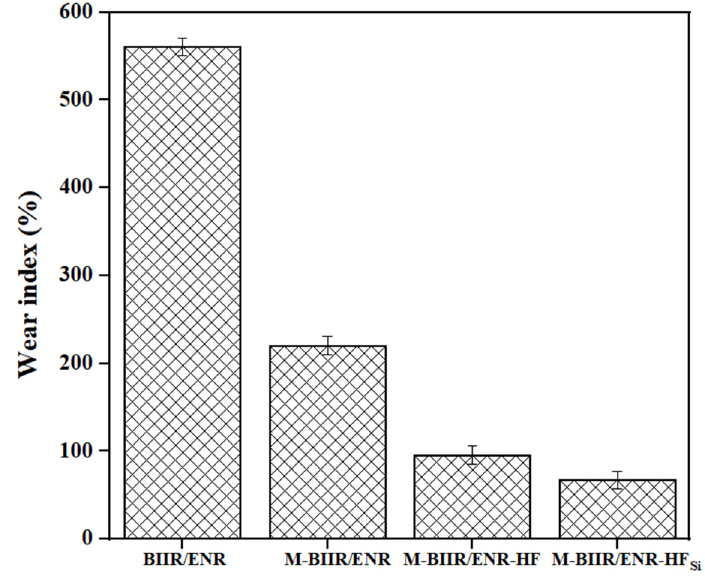
Figure 7. Wear index of unmodified BIIR and the M-BIIR/ENR composites filled with CNT/CB with and without the addition of TESPT.